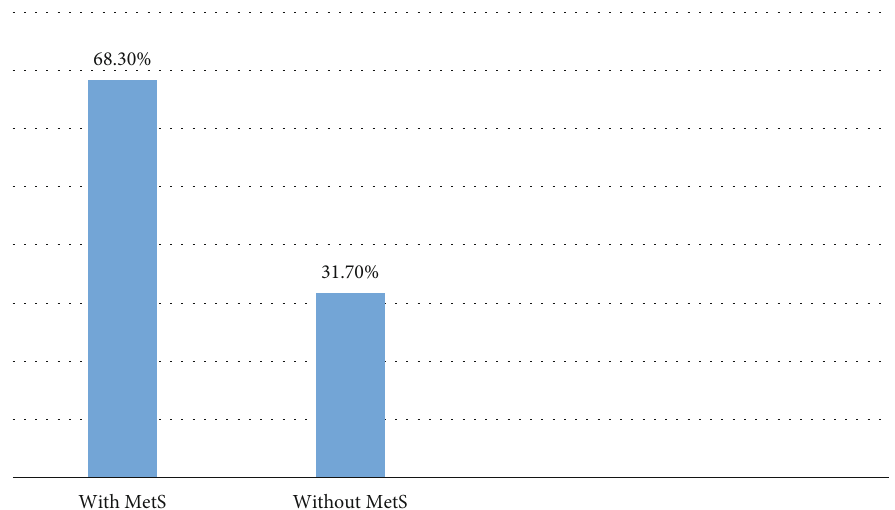
Figure 2: Metabolic syndrome of type 2 diabetic patients at hospitals in Ilu Aba Bora and Buno Bedele zones, Southwest Ethiopia,